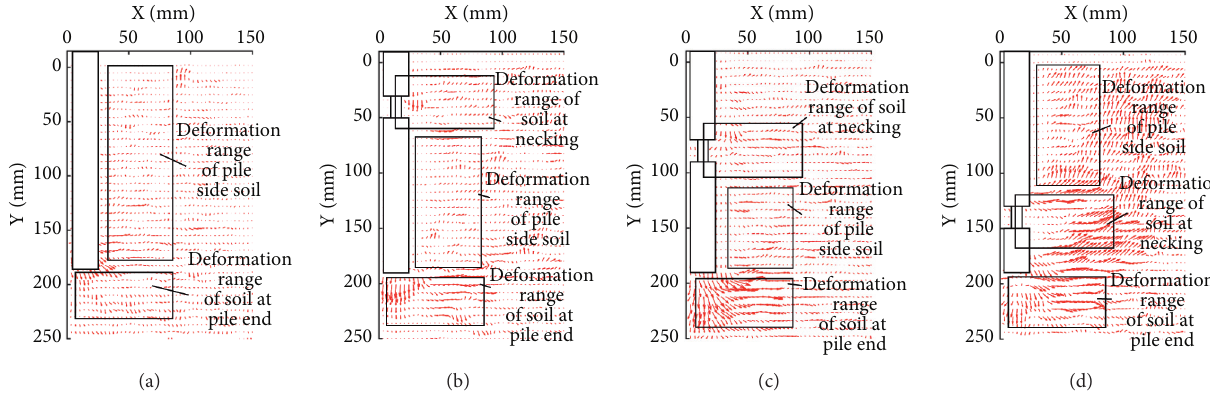
Figure 11: Displacement vector diagram of soil around the single pile under 260N load level. (a) Intact pile. (b) Necking in the shallow pile body. (c) Necking in the middle pile body. (d) Necking in the deep pile body.